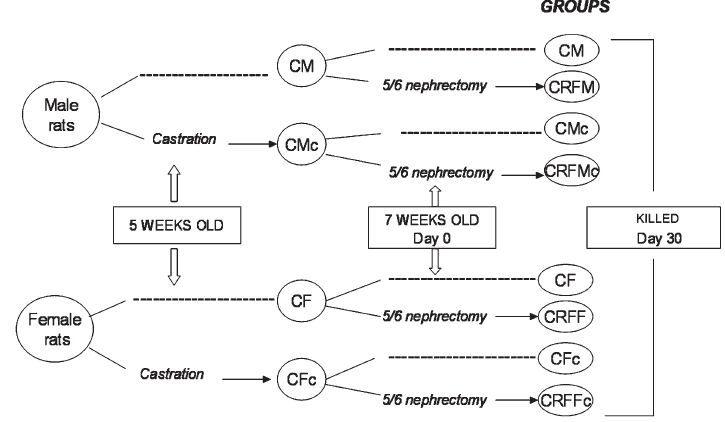
Figure 1. Schematic representation of the study design combining castration and CRF. C: control; c: castration; CRF: chronic renal failure; F: female rat; M: male rat; dashed line: no surgical